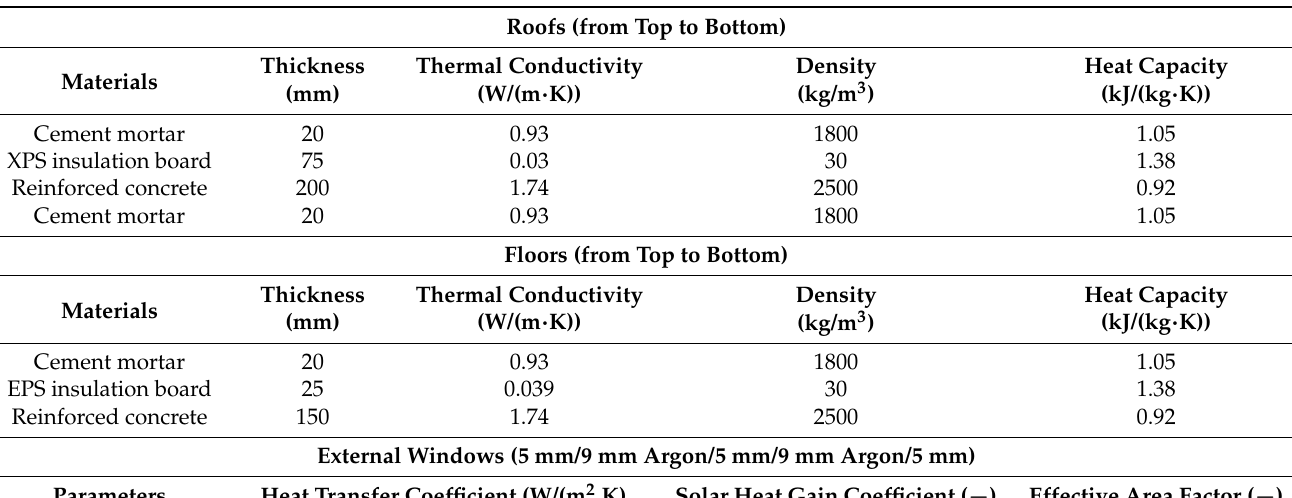
Table 2. Cont. Roofs (from Top to